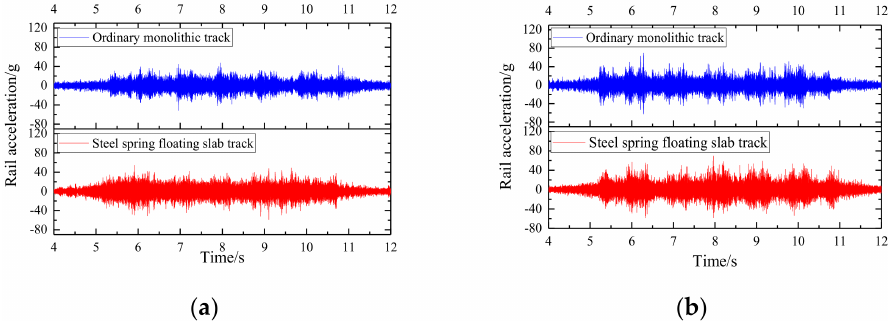
Figure 9. Comparison of vertical acceleration of rail. ( a ) Straight line segment; ( b ) curved segment.